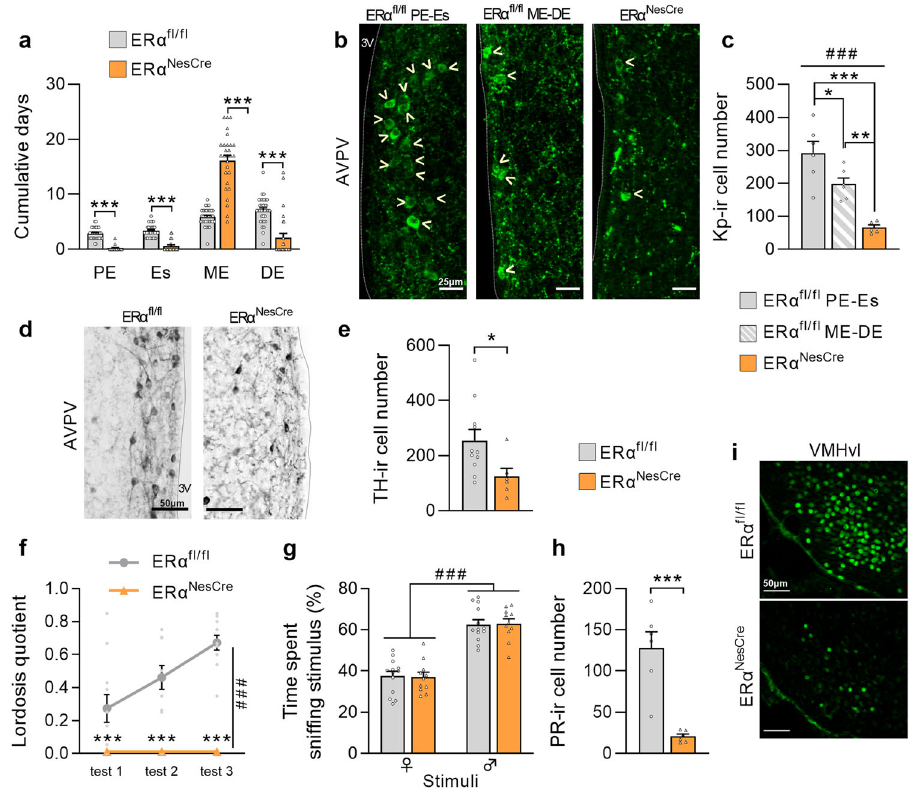
Fig. 2 Neural ER α deletion induced severe de fi cit of female reproductive function and behavior. a Cumulative days in stages of the estrous cycle for control (ER α fl / fl ) and mutant females (ER α NesCre ). PE proestrus, Es estrus, ME metestrus, DE diestrus. Data are means ± S.E.M. for 28 – 35 females